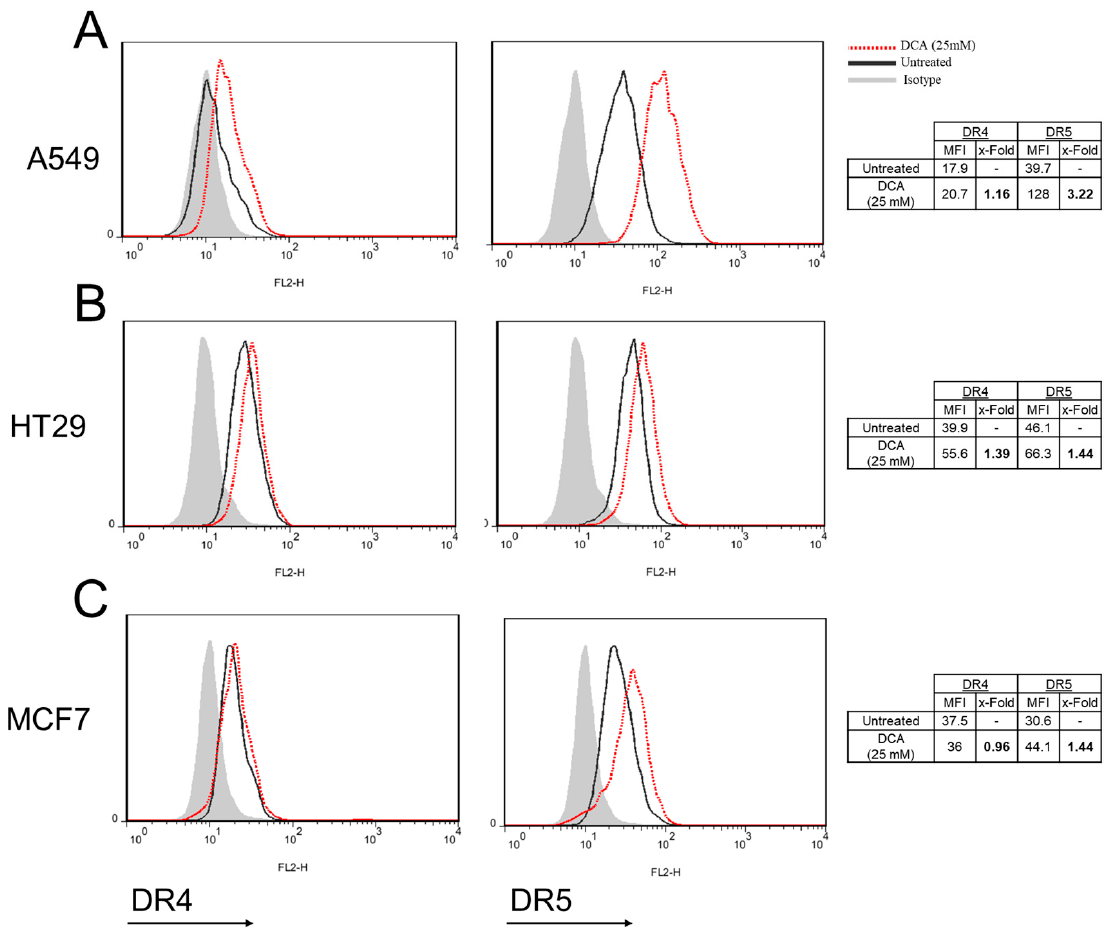
Figure 6. DR4 and DR5 surface expression after DCA exposure. ( A ) A549, ( B ) HT29, and ( C ) MCF7 cells were incubated for 72 h with DCA (25 mM) and then DR4 and DR5 levels were measured by flow cytometry. Bold numbers in the right tables represent the ratio between treated cells vs untreated cells (x-Fold). DCA: dichloroacetate.